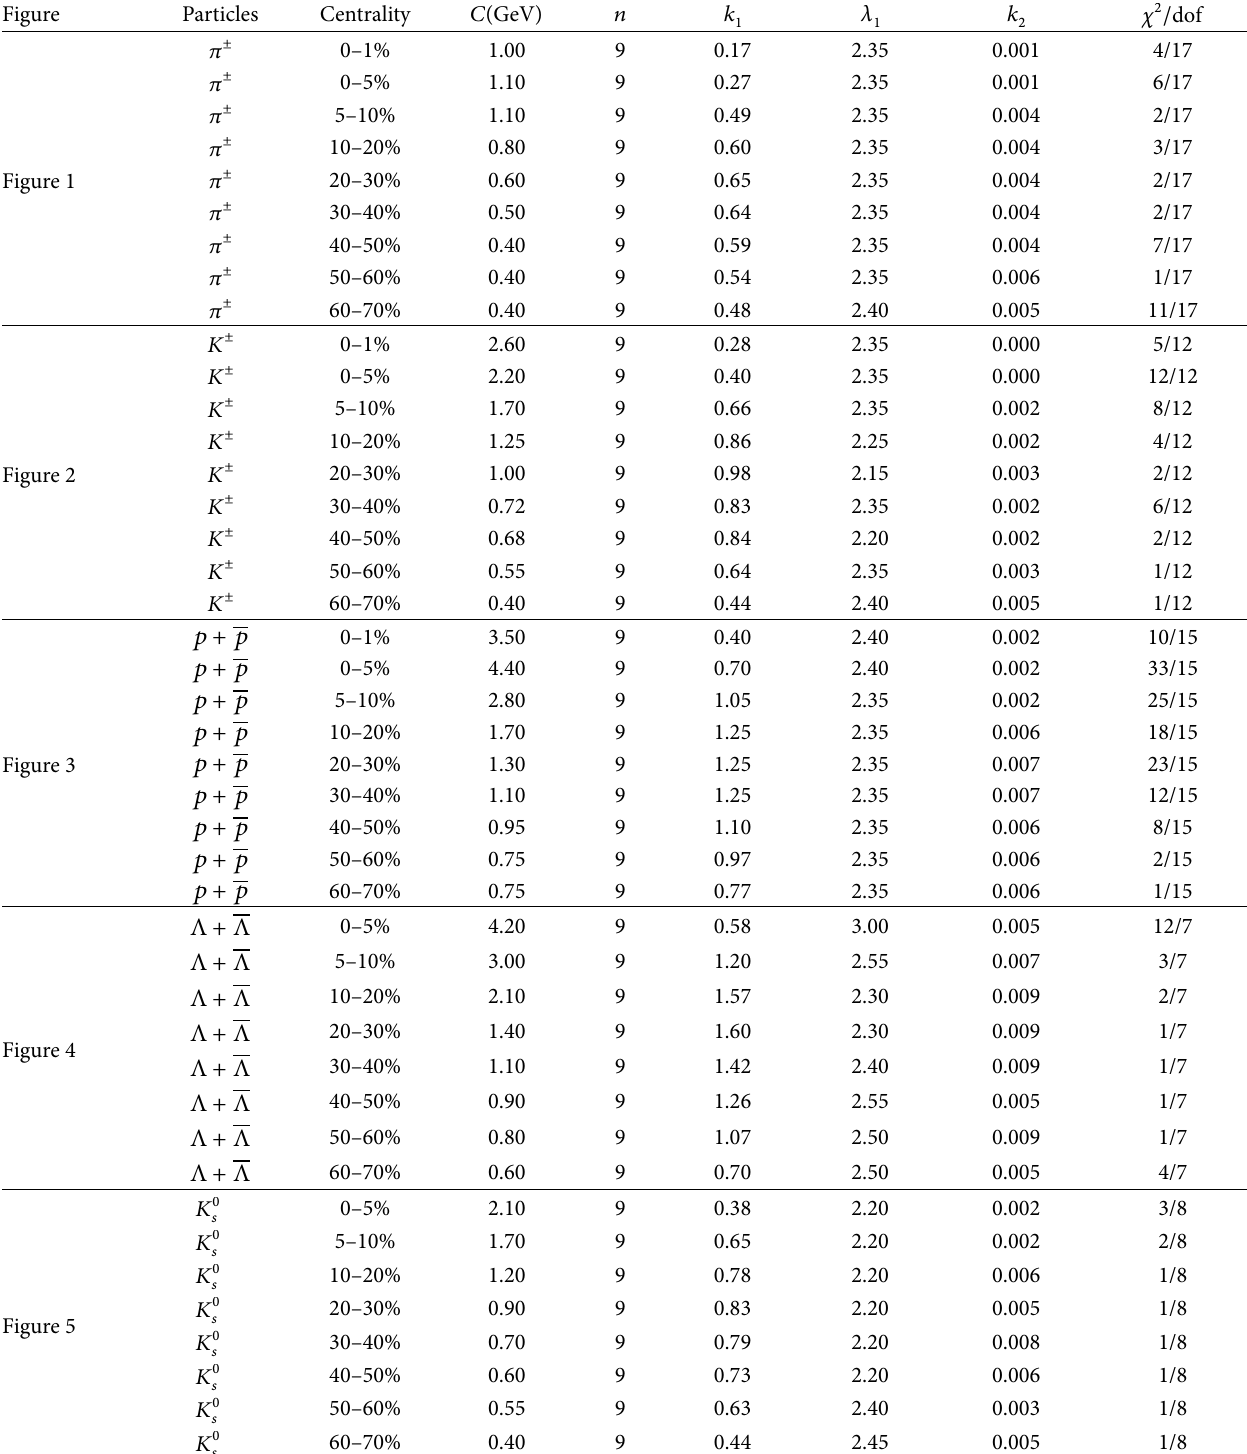
Table 1: Values of 𝐶 , 𝑛 , 𝑘